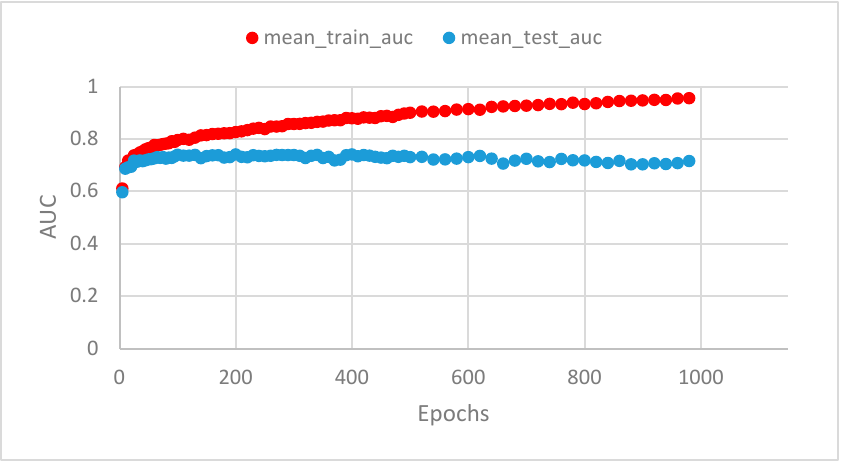
Figure 1. Underfitting and overfitting examples on randomized data with 1, 50, and 4 degree model.